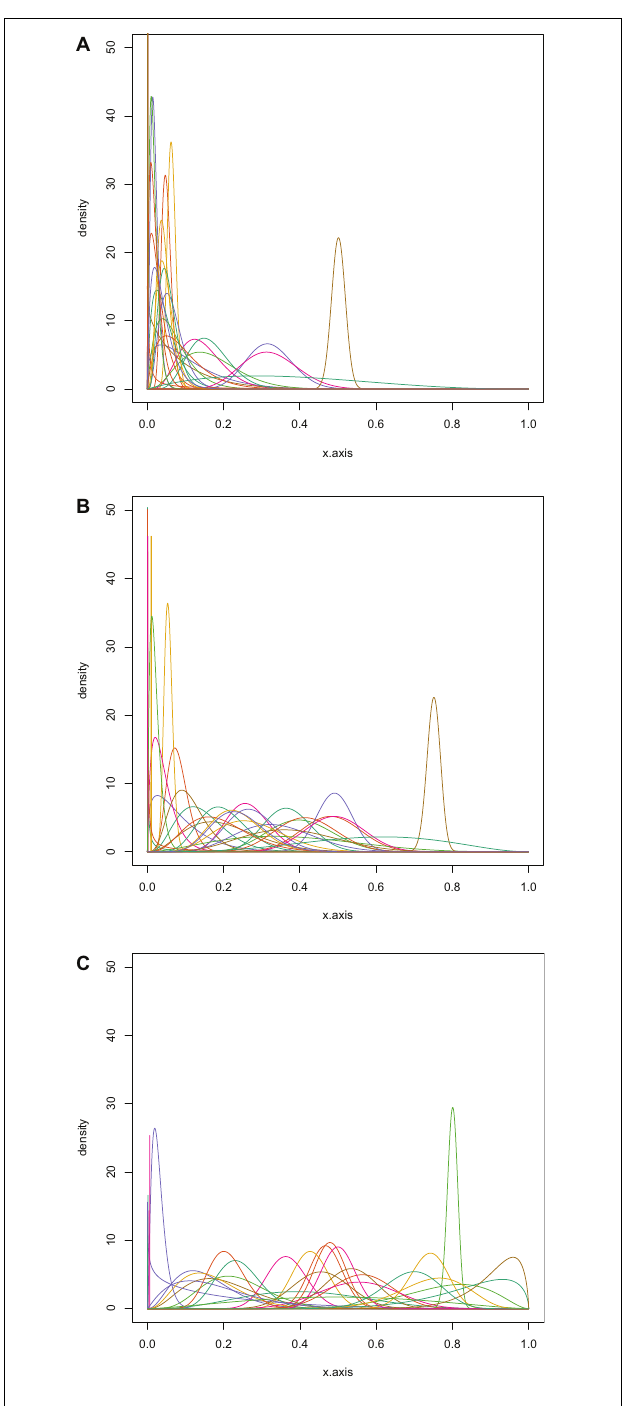
FIGURE 2 | The parametric beta distributions based on the experts’ stickered distributions for Scenario 1 ( A ; n = 34), 2 ( B ; n = 35) and 3 ( C ; n =